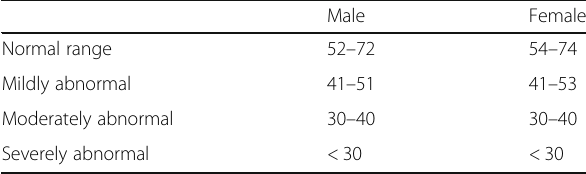
Table 1 Normal ranges and severity partition cut-off values